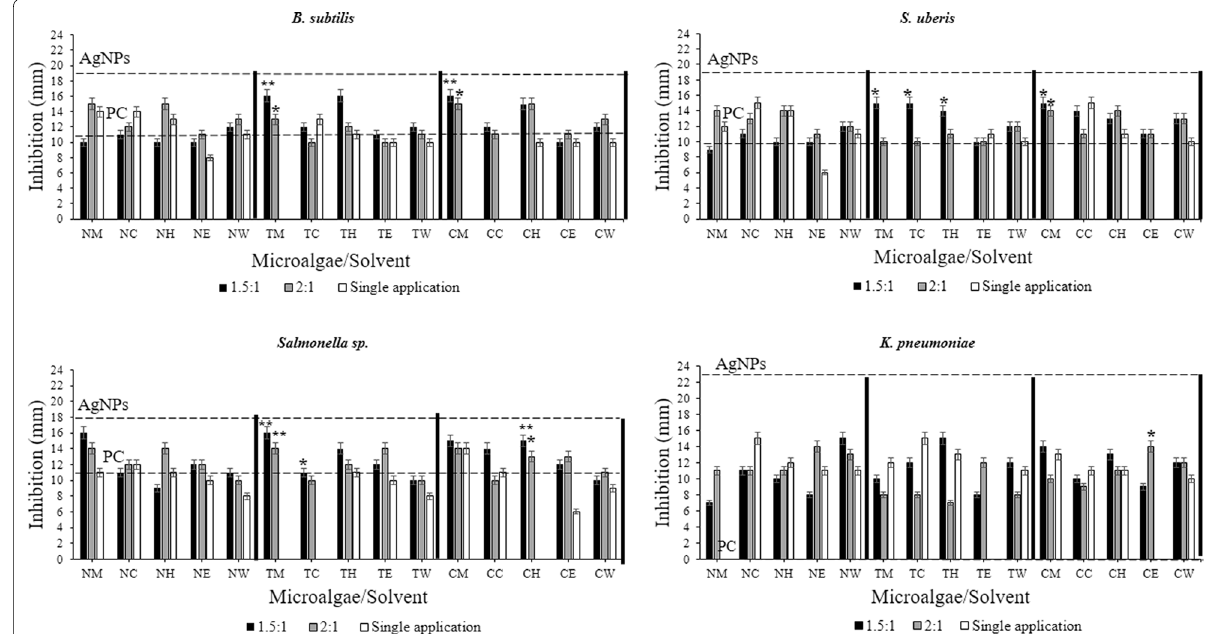
Fig. 1 Inhibitory effects (mm) of AgNPs and MCEs (500 µg/mL) single and co-application at the 1.5:1 and 2:1 ratio on selected microorganisms for 24 h by using well diffusion methods. The results are expressed as the mean dashed lines indicate the inhibitory zones of AgNPs and PC (N– N. oculata ; T– T. suecica ; C- Chlorella ; M-methanol; C-chloroform; H-hexane; E-ethanol;